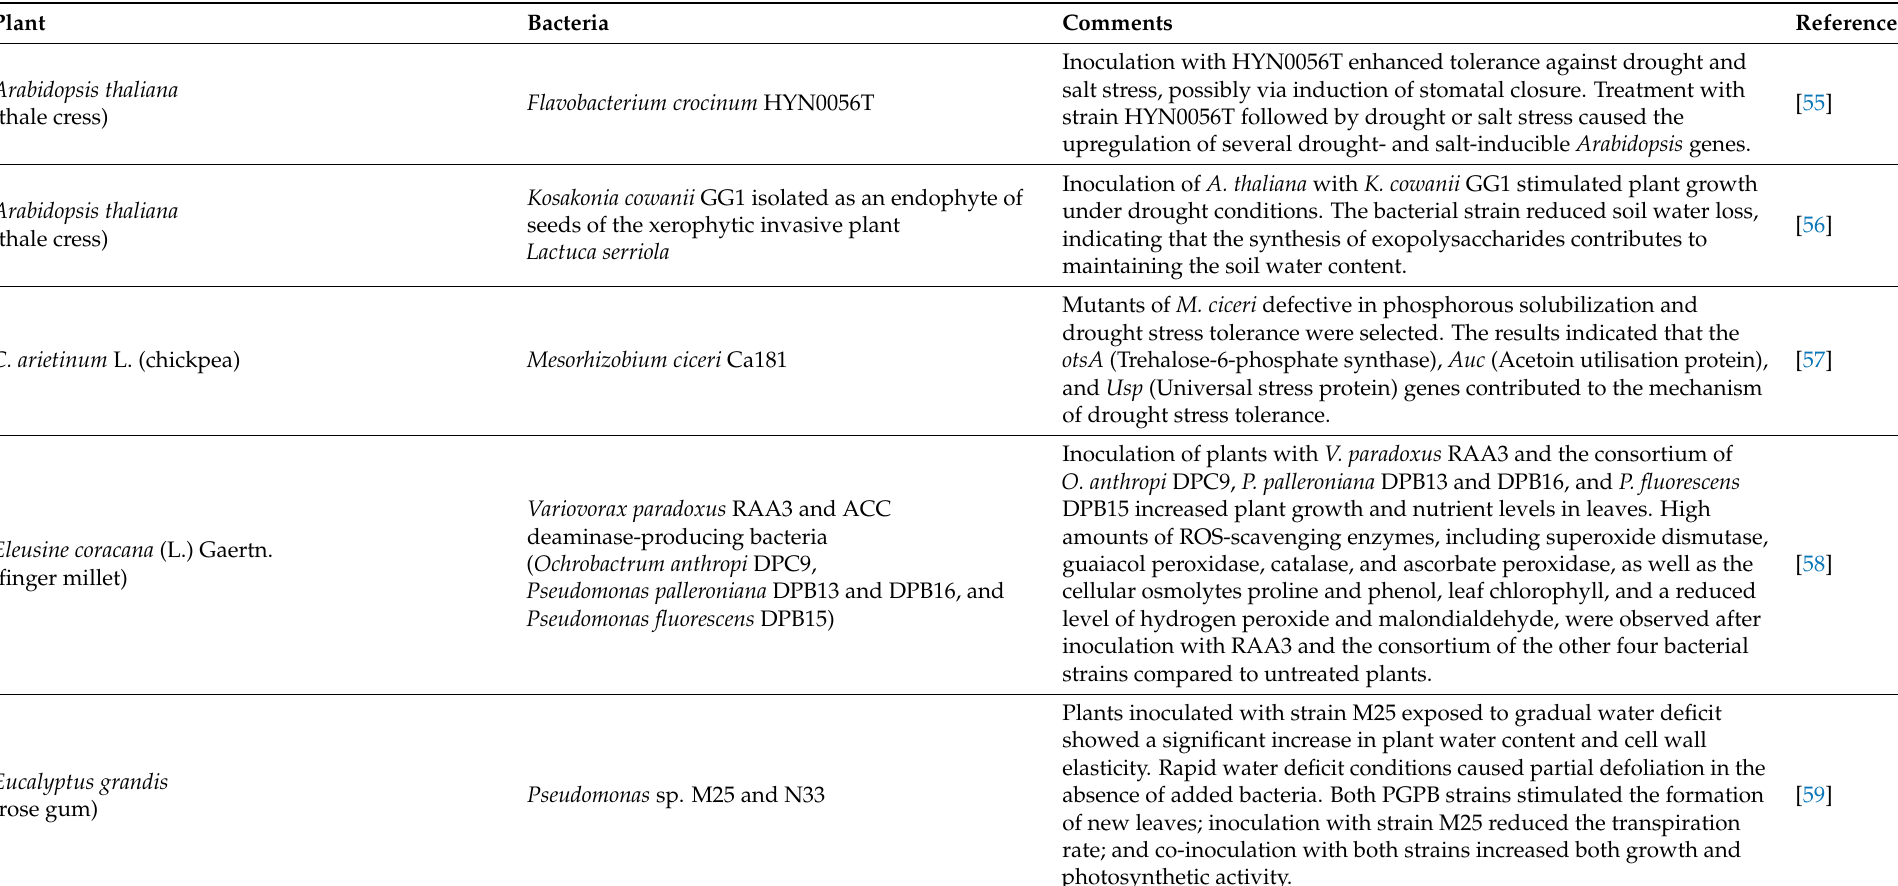
Table 1. Recent studies indicating how PGPB help to ameliorate drought